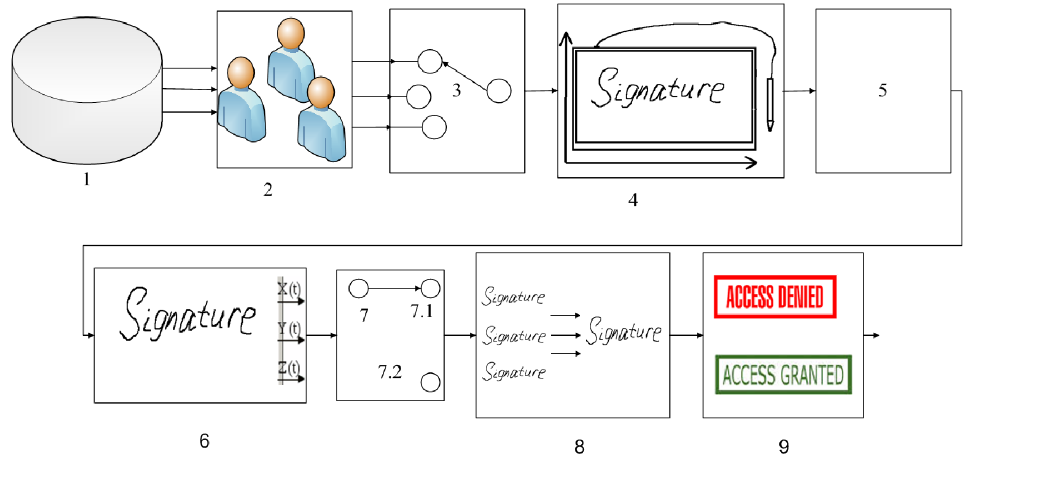
Figure 2. The structural diagram describes the identification process: 1 —the signature database; 2 —the signature generators; 3 —an employee’s commutator; 4 —a graphics